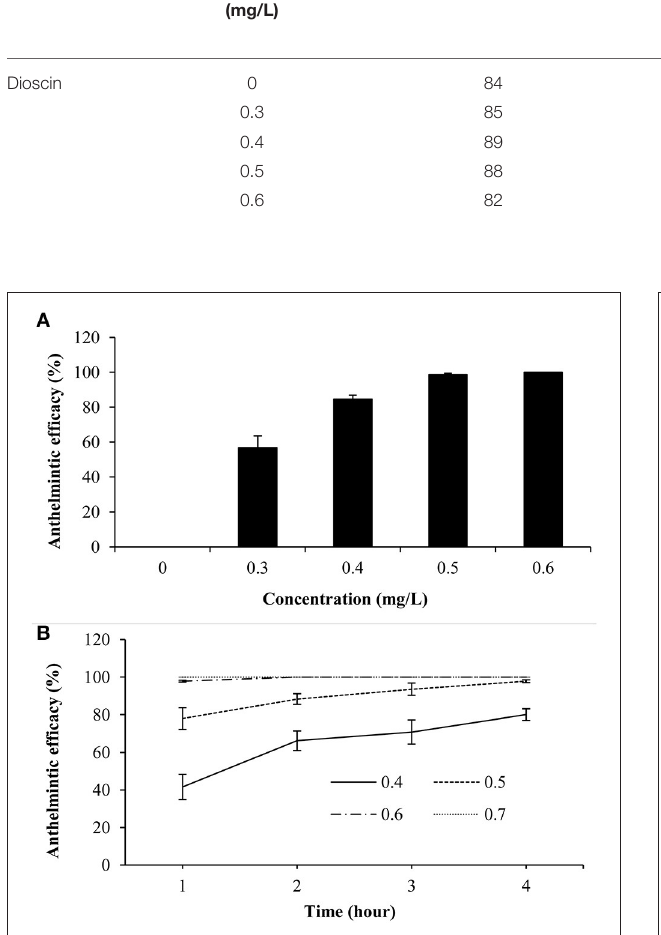
FIGURE 4 | Antiparasitic efficacy of dioscin against Gyrodactylus kobayashii after 24-h treatment in vivo (A) ; the effect of different concentrations of dioscin on the survival time of Gyrodactylus kobayashii in vivo (B) .